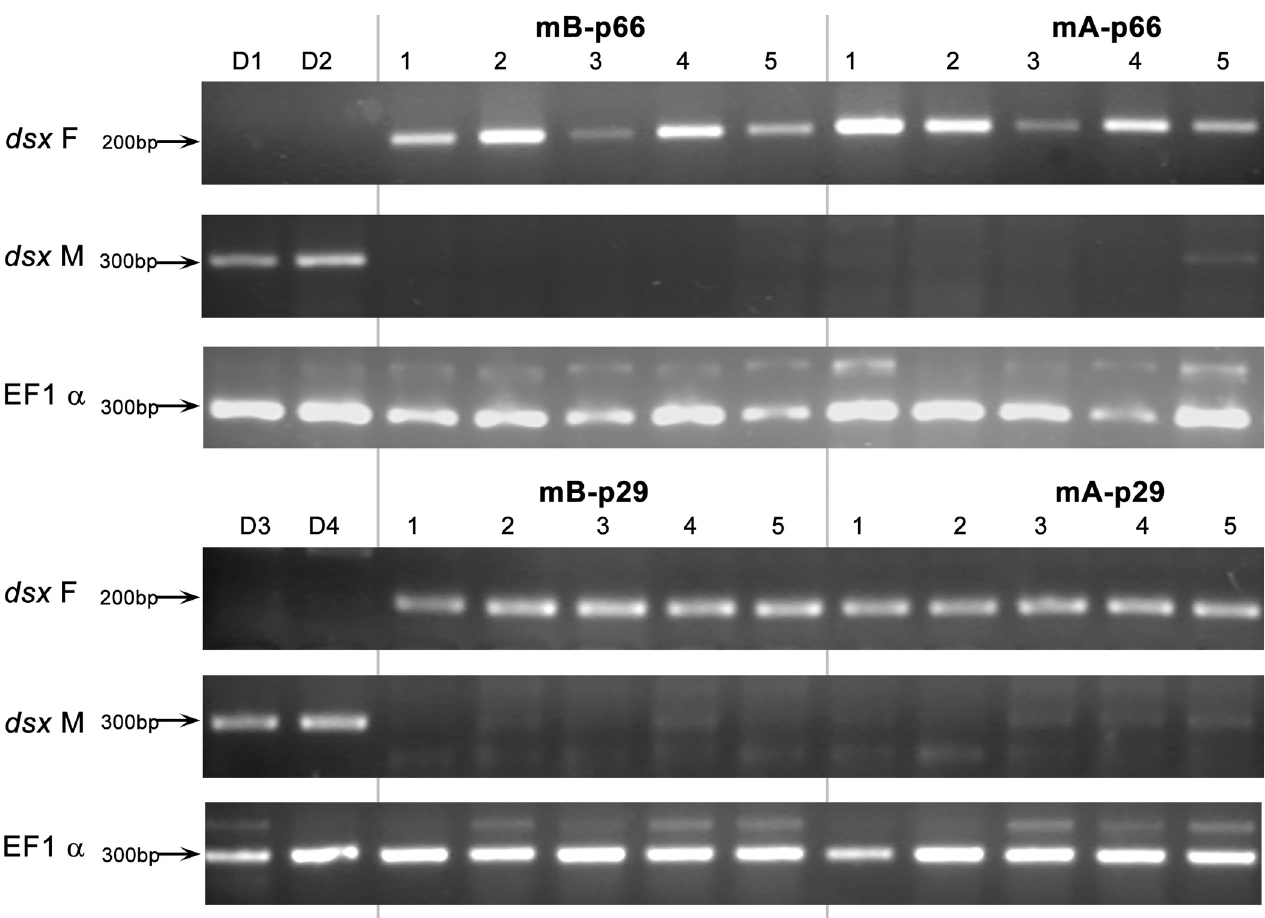
Fig 6. RT-PCR analysis of female- (dsxF) and male-specific (dsxM) splice variants expression of dsx gene in individuals possessing mB-p66 and mA-p66 and mB-p29 and mA-p29 genotypes. Numbers 1–5 depict randomly chosen representants of each genotype, D1-4: drone individuals used as controls. Amplification of EF1 α gene was used as a positive